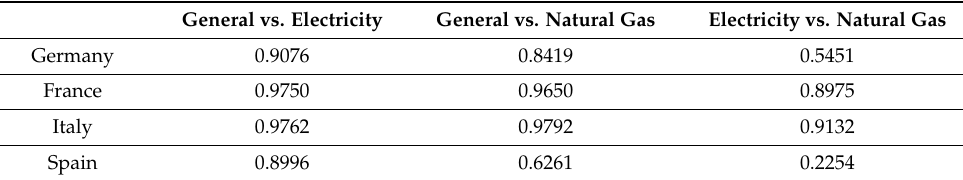
Table 5. ESL correlations for analyzed countries. Source: own research. General vs. Electricity General vs. Natural Gas Electricity vs. Natural